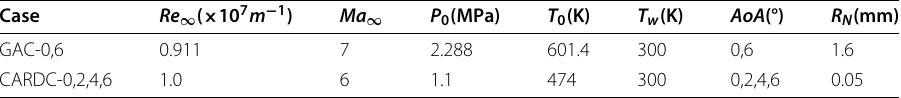
Table 1 The flow parameters of the test cases